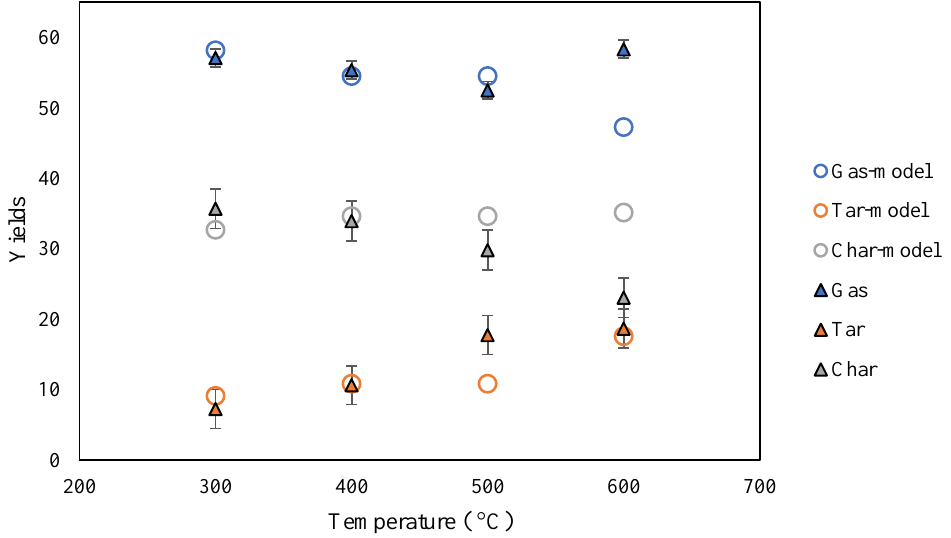
Figure 5. Comparison between experimental data and yields predicted by the model during pyrolysis as a function of maximum pyrolysis temperature.